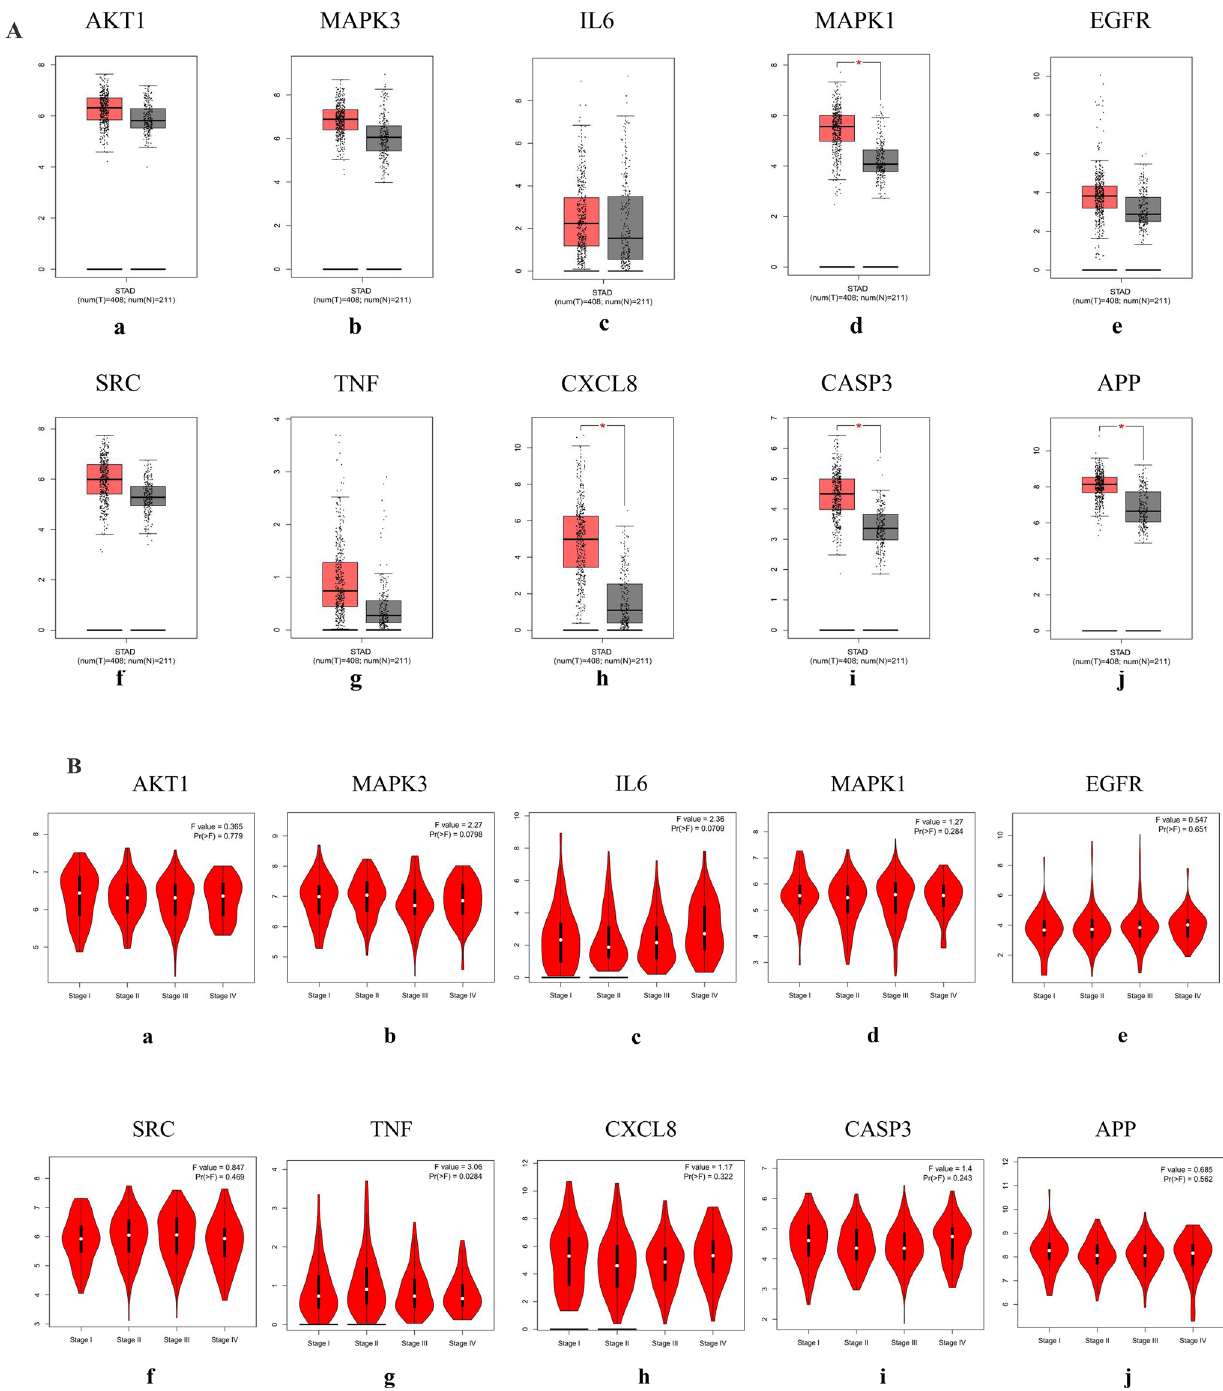
Figure 11. mRNA expression level, pathological stage, and OS of hub targets. ( A ) Box plots showing the mRNA expression levels of (a) AKT1, (b) MAPK3, (c) IL6, (d) MAPK1, (e) EGFR, (f) SRC, (g) TNF, (h) CXCL8, (i) CASP3, and (j) APP. Red represents tumor, gray represents normal. ( B ) The violin diagram shows the stage plot of mRNA expression level and pathological stage in the GEPIA database. ( C ) The line charts show the OS of hub targets. The survival curve comparing the patients with high (red) and low (blue) expression in